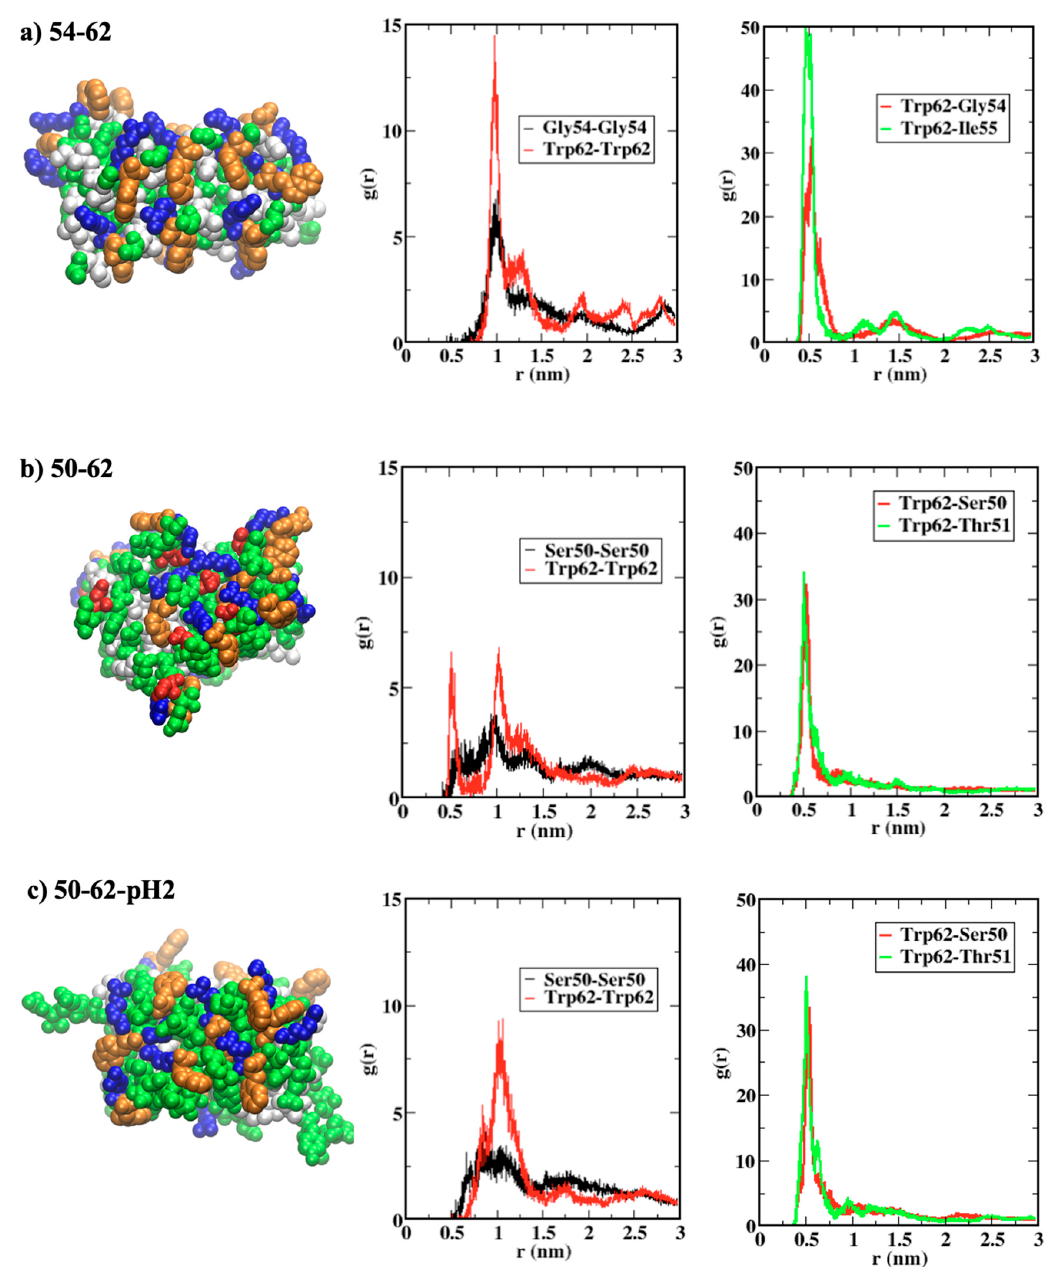
Figure 5. ( a – c ) ( left ) conformational snapshots after 100 ns showing terminal residues Trp62 in orange, positively charged residues in blue, negatively charged residues in red, polar uncharged residues in green, and hydrophobic residues in white, ( middle – right ) radial distribution functions (RDF) between pairs of terminal residues.